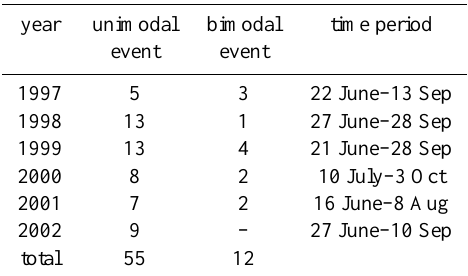
Table 2. Number of runoff events for the two event